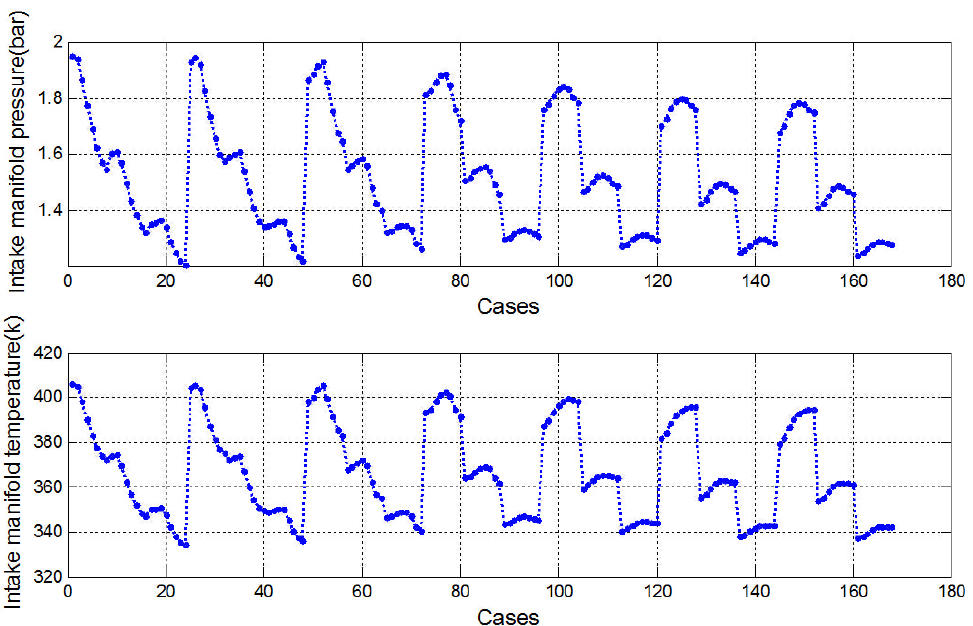
Figure 3. Intake manifold pressures and temperatures in steady